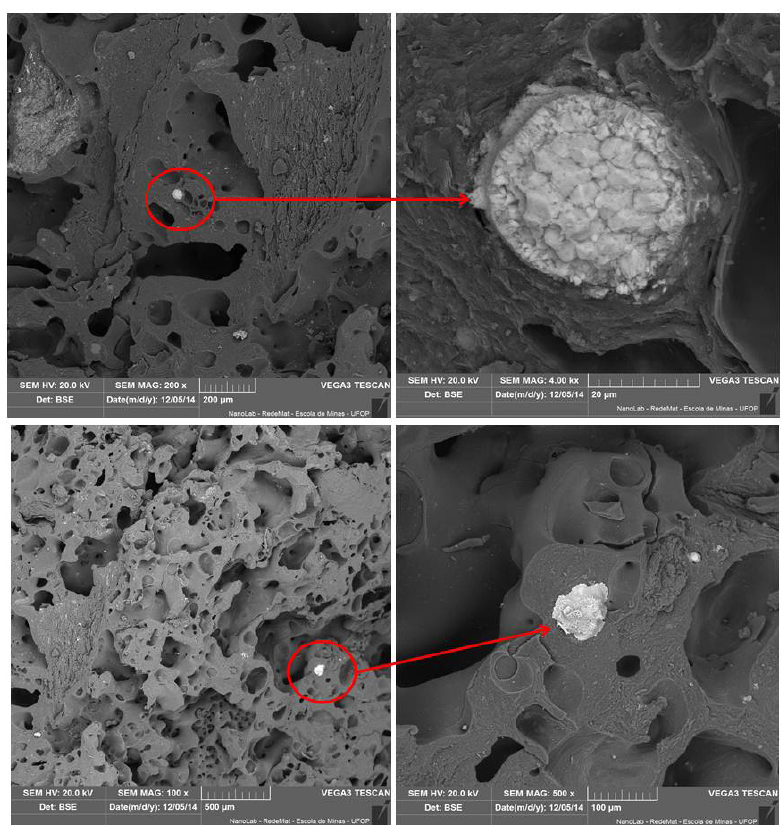
Figure 8. Scanning Electron Microscopy coke with steel mesh to eat coke condition of MT 3%.